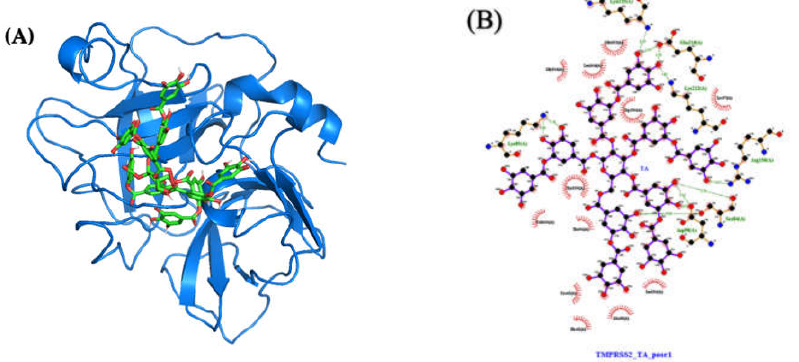
Figure 10. Molecular structures after 1000 ns of MD: ( A ) TA/TMPRSS2 complex (pose 1; MMPBSA binding free energy of −68 kcal/mol) and ( B ) ligand interaction map. The interaction map of TA with TMPRSS2 is shown from the center of the biggest cluster computed on the convergence interval using the protein backbone atoms and ligand non-hydrogen atoms. The other contacts, defined by a distance smaller than 0.40 nm between the ligand and the protein, are shown as red arcs. H-bonds and their donor/acceptor distances are shown in green. The interaction map is generated using LigPlot [50,51].